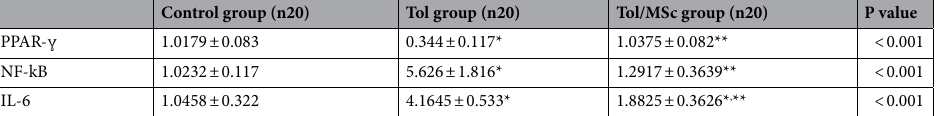
Table 2. Statistical comparison of gene expression of peroxisome Proliferator-Activated Receptor-Gamma (PPAR- ɣ ), Nuclear Factor kappa B (NF-kB), and Interleukin-6 (IL-6). One-way ANOVA, and Tukey HSD Post-hoc Test, P > 0.05: no significant differences, P < 0.05: significant differences. *Significant vs control group. **Significant vs Tol